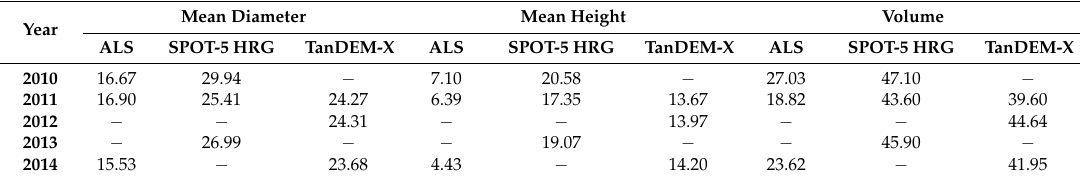
Table 4. Relative RMSE (%) for the selected regression